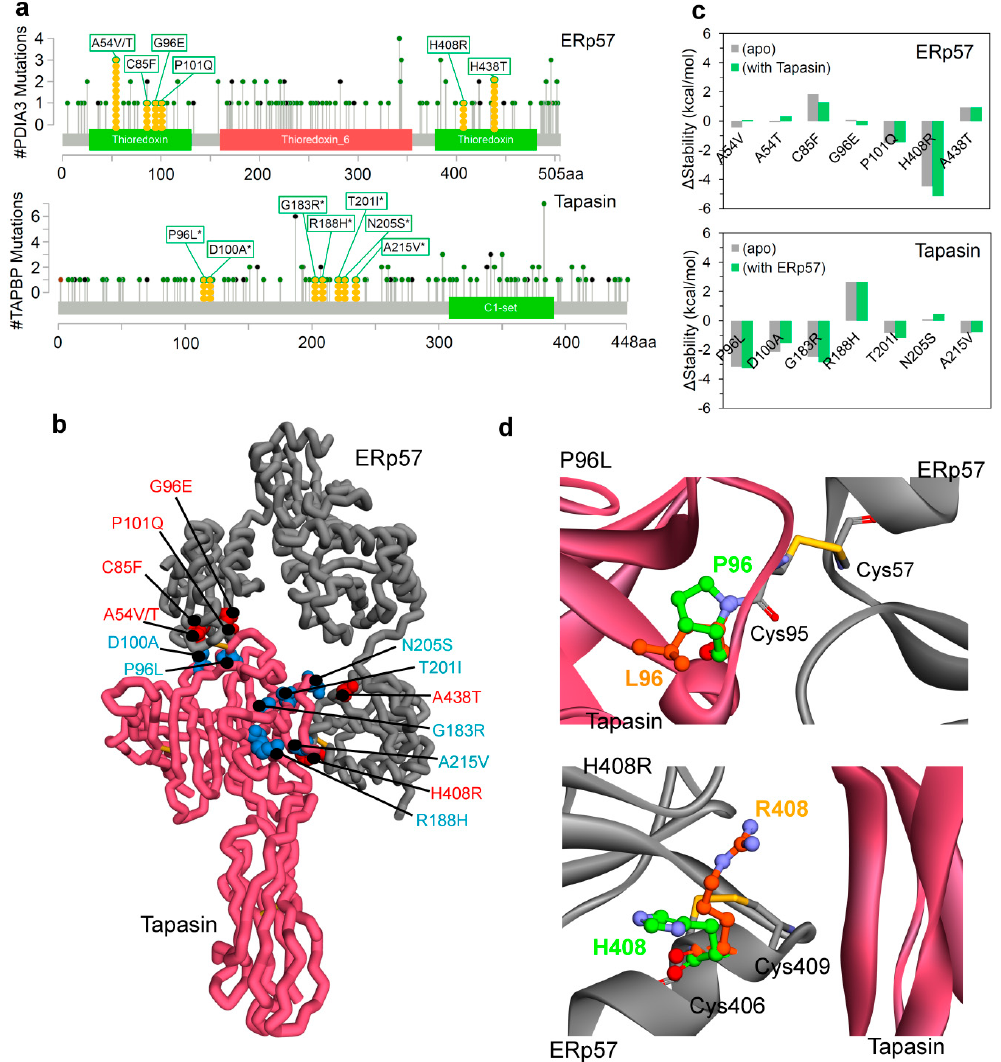
Figure 2. Residues of ERp57 and tapasin proteins that were found mutated in different cancer types. ( a ) Mutation data retrieved from the cBioPortal for PDIA3 (ERp57) and tapasin(TAPBP) genes